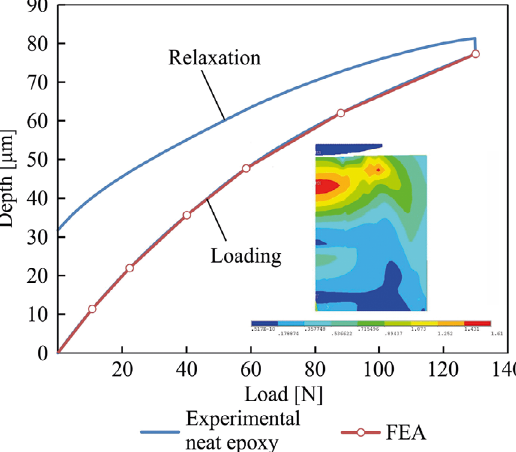
Figure 9. FEA-determined impression from the ball indentation through the developed FEA simulation and a typical stress contour.